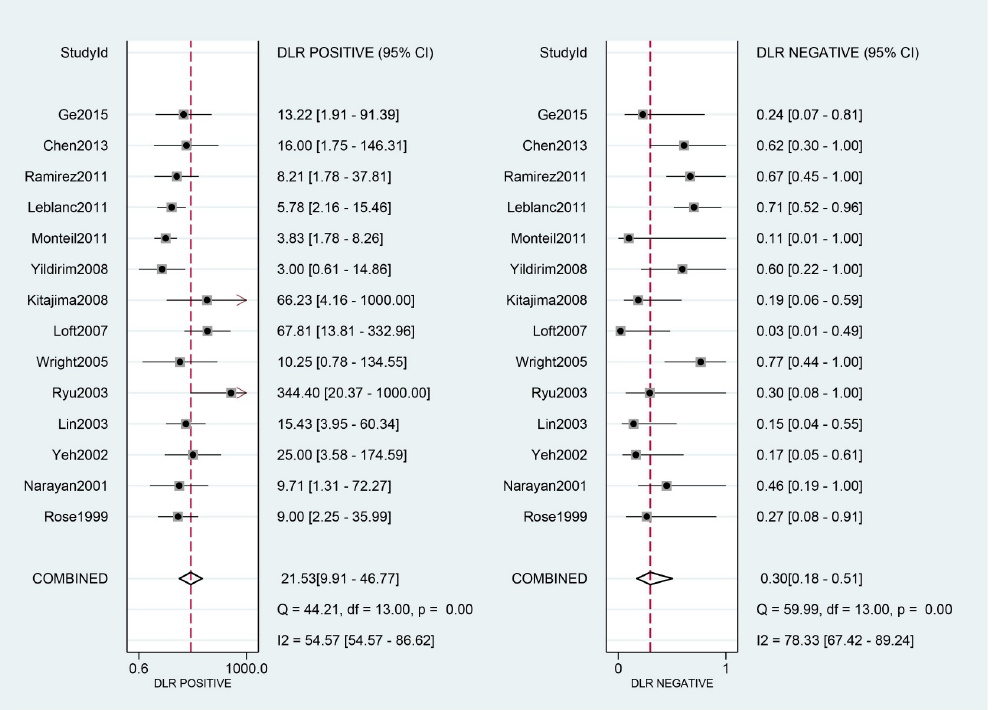
Fig 4. Forest plots for positive and negative LRs. Abbreviations: CI, confidence interval; df, degrees of freedom; LR, likelihood ratio.